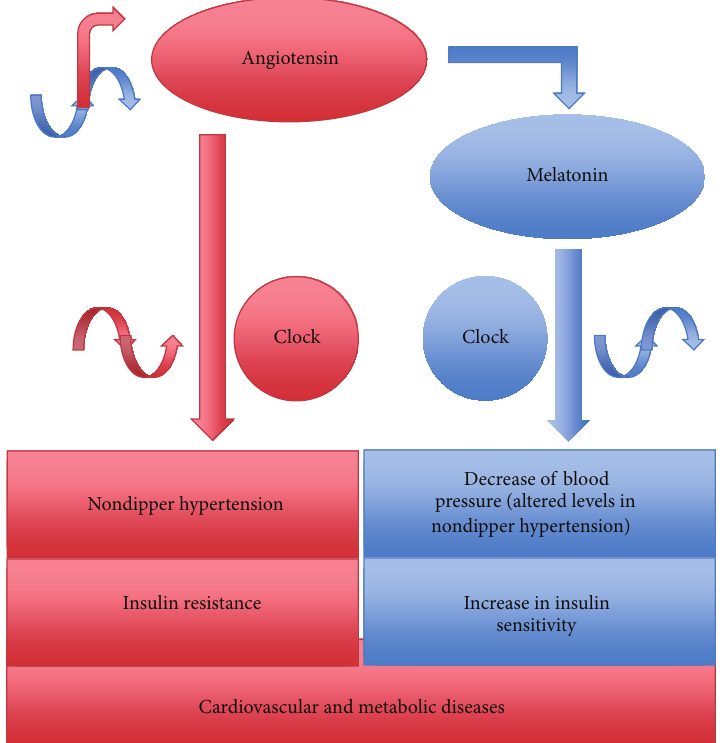
F 2: Angiotensin versus melatonin in cardiovascular and metabolic diseases. An increase in angiotensin induces nondipper/riser hypertension, which is characterized by a decrease in melatonin. Angiotensin and melatonin have opposing effects on insulin